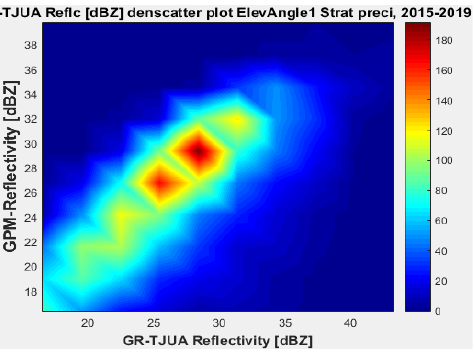
Figure 7. GPM ‐ Ka vs. NEXRAD TJUA for stratiform precipitation (angle 1). Figure 7. GPM-Ka vs. NEXRAD TJUA for stratiform precipitation (angle